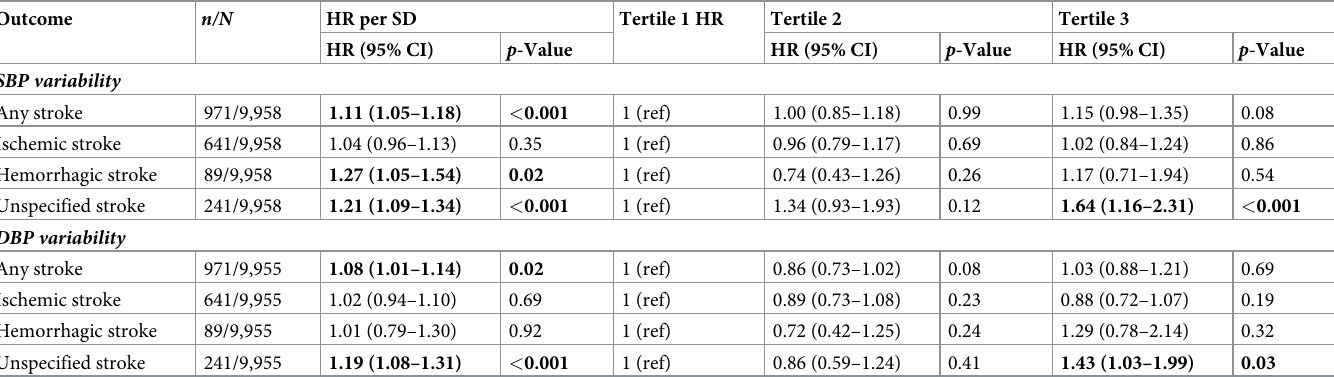
Table 2. Association between systolic blood pressure variability and risk of incident any stroke, ischemic stroke, hemorrhagic stroke, and unspecified stroke AU : PleasecheckthattheeditstothecolumnheadsandlegendforTable 2 captureyourmeaning : Ifnot ; pleaseeditasnecessary : Note : Imovedthedefinitionsofthetertilestothetablelegendbecause ; perPLOStablestyle ; columnheadinfomustapplytotheentirecolumn ð whichisnotthecaseforthetertiledefinitions ; whichdifferedbetweenSBPvariabilityandDBPvariability Þ :